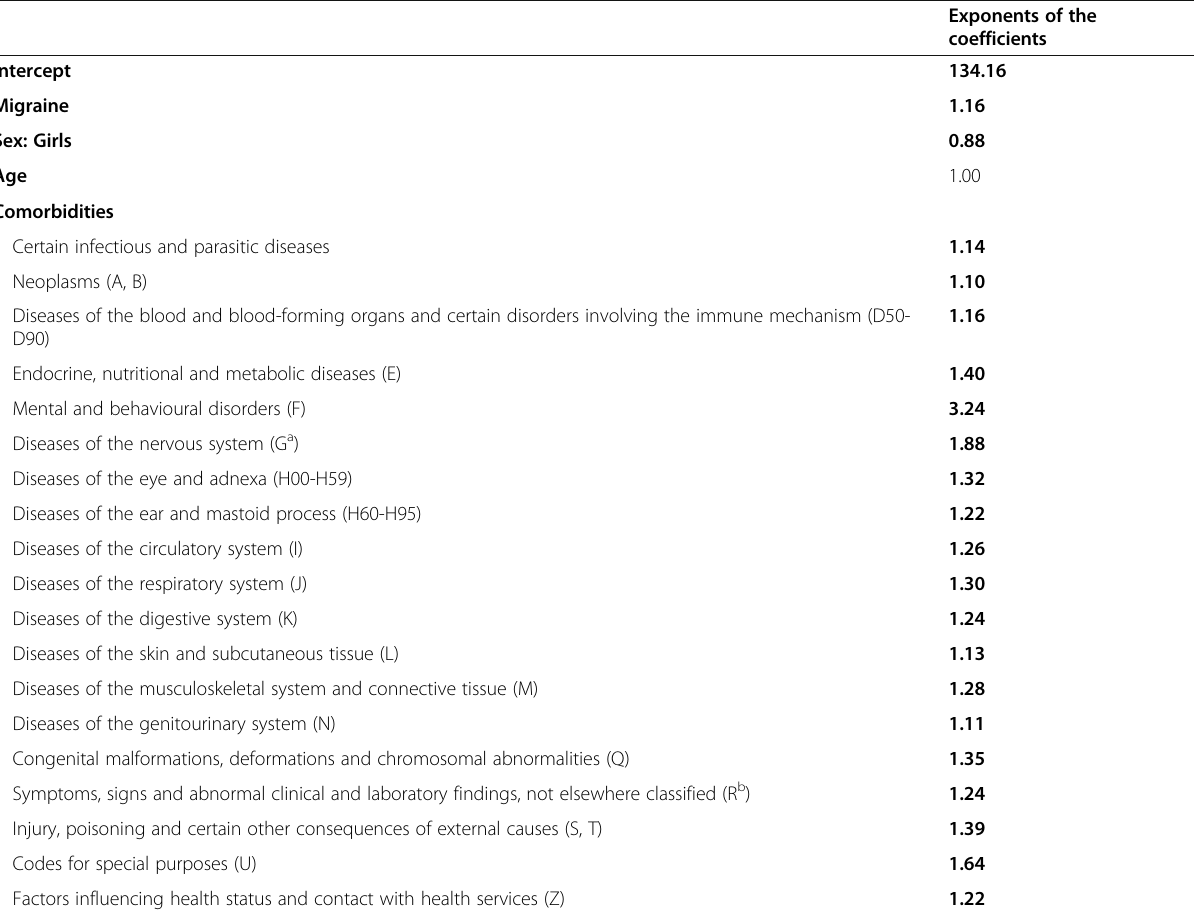
Table 3 Gamma regression model factors influencing annual total health care costs: migraine, sex and age were preset, comorbidities selected by the Bayesian Information Criterion (BIC). Exponents can be interpreted as multiplicative cost factors. Estimates with p < 0.05 are printed in bold